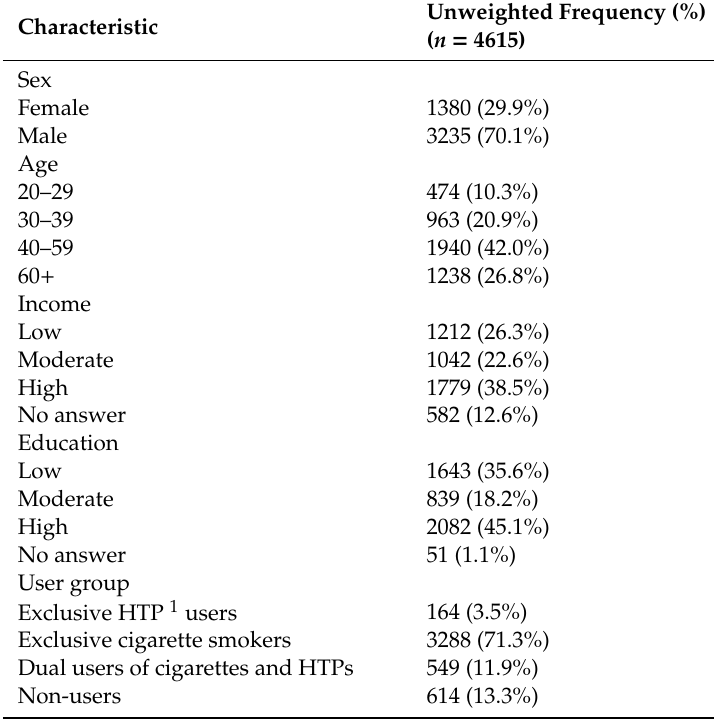
Table 1. International Tobacco Control (ITC) Japan Wave 1 Survey Sample Characteristics. Characteristic